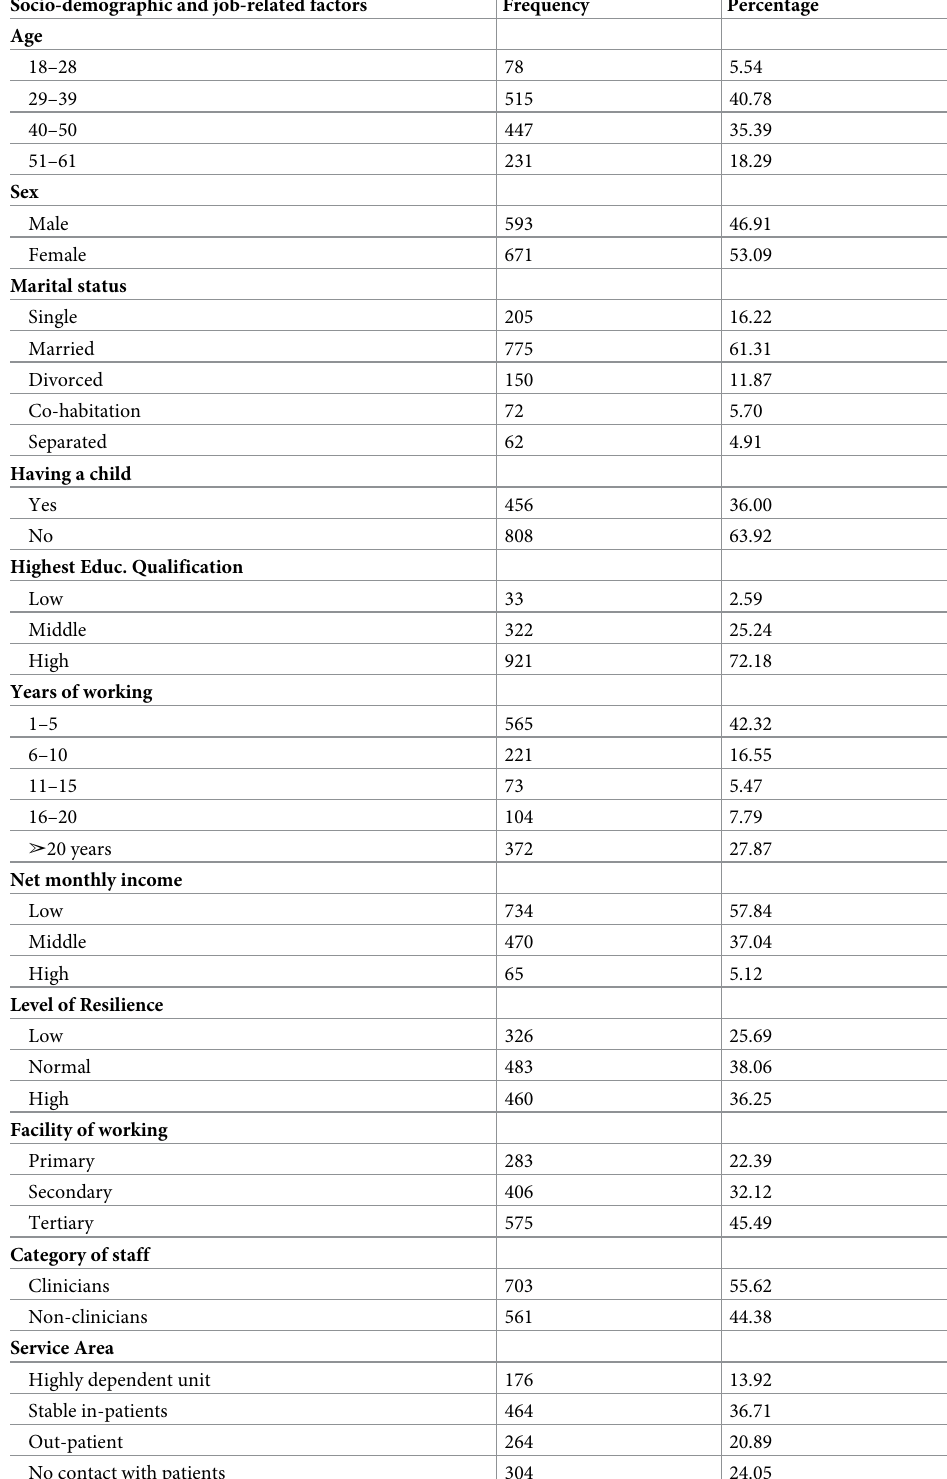
Table 1. Socio-demographic and job-profiles of participants. Socio-demographic and job-related